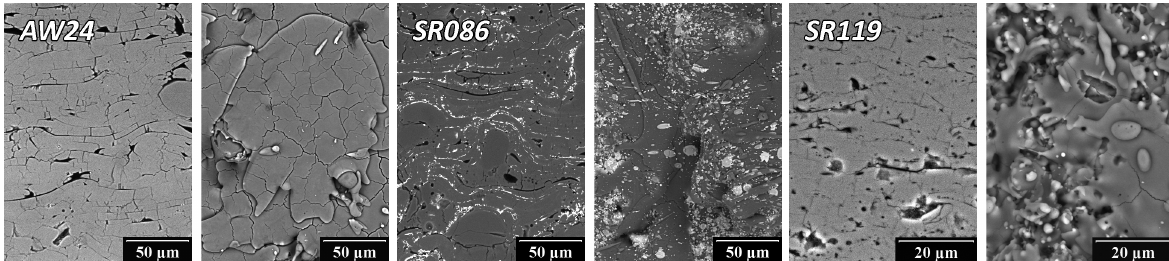
Figure 2. Coatings microstructure. Cross-section (left) and free-surface (right). Bright spots in SR086 coating are YSZ splats. SEM.